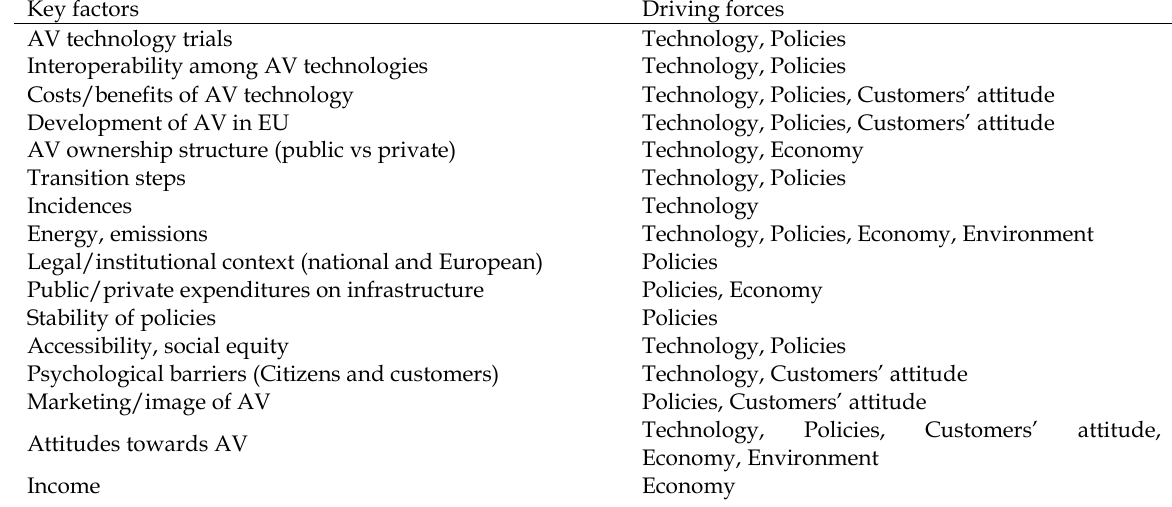
Table 1. The key factors and drivers of automated vehicles development in the Netherlands as identified in the